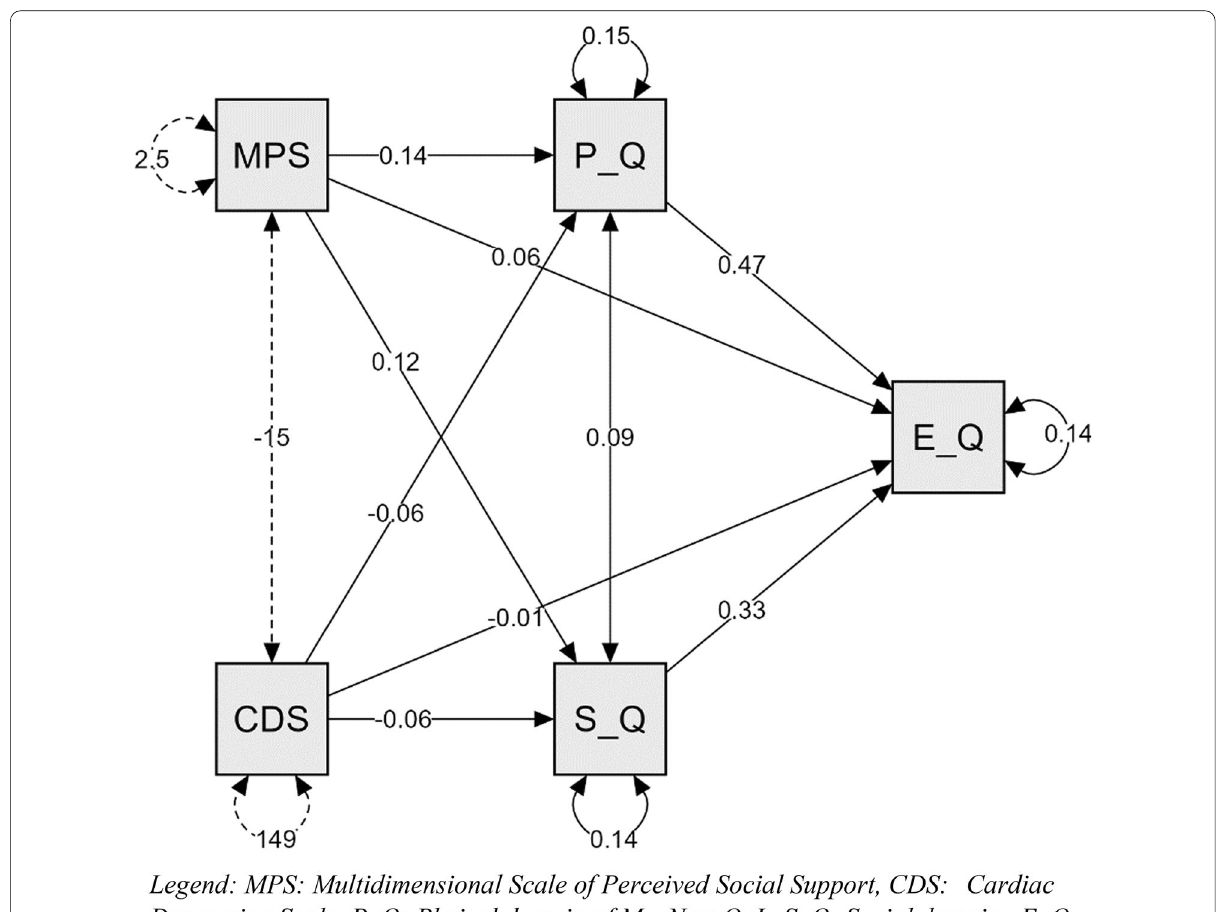
Fig. 2 Multiple mediation plot with non‑standardized